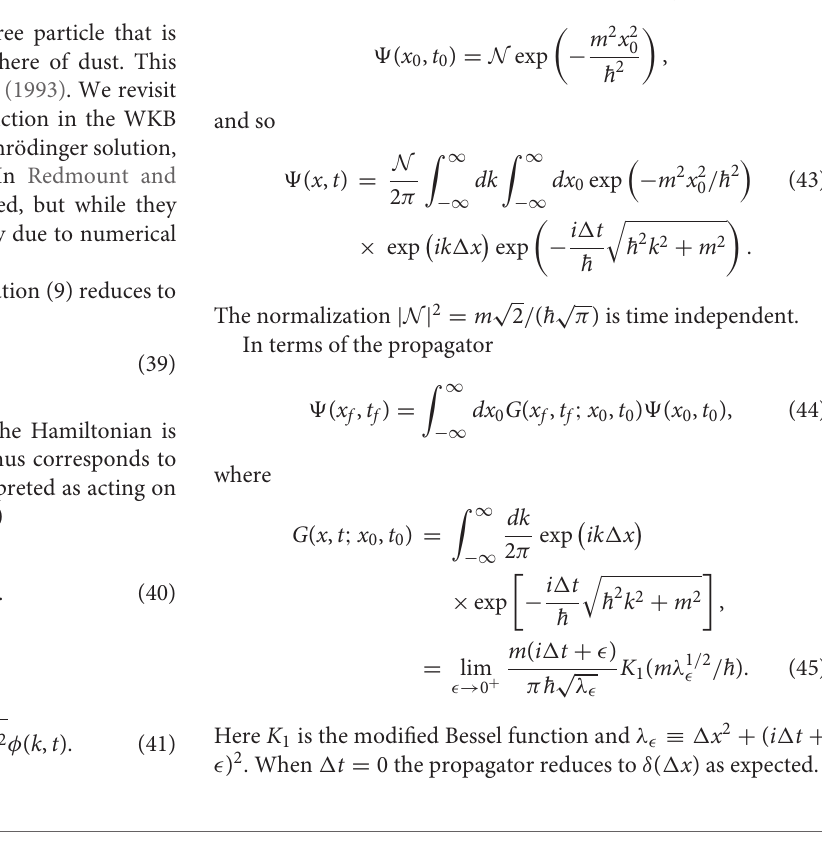
TABLE 5 | The classical action in various regions. c 1 > 0 (direct